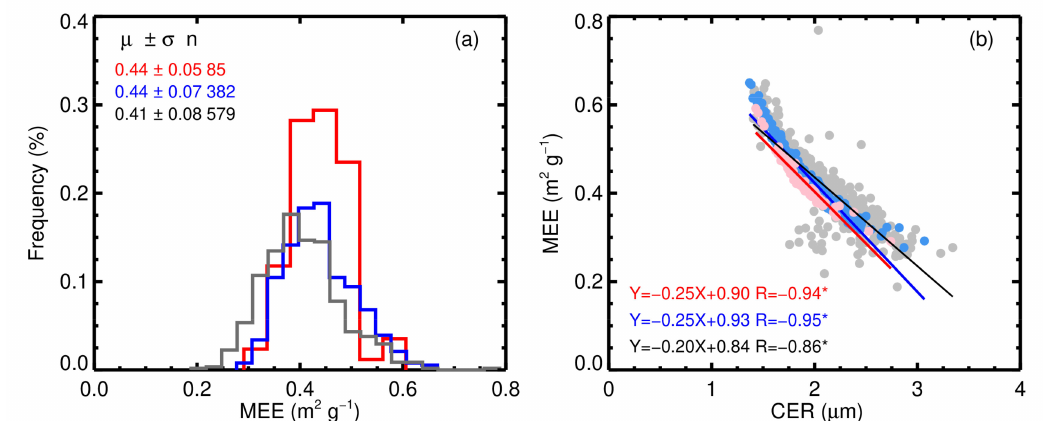
Figure 4. ( a ) Frequency distribution of the dust mass extinction efficiency (MEE) and ( b ) relationship between the dust MEE and CER for the DD (red), PD-I (blue), and PD-II (gray) conditions. The average ( µ ), SD ( σ ), and sample size ( n ) of the dust MEE for different conditions are labeled in the left panel. The fitting function and correlation coefficients ( R ) at different conditions are labeled in the right panel (* represents the significant level of